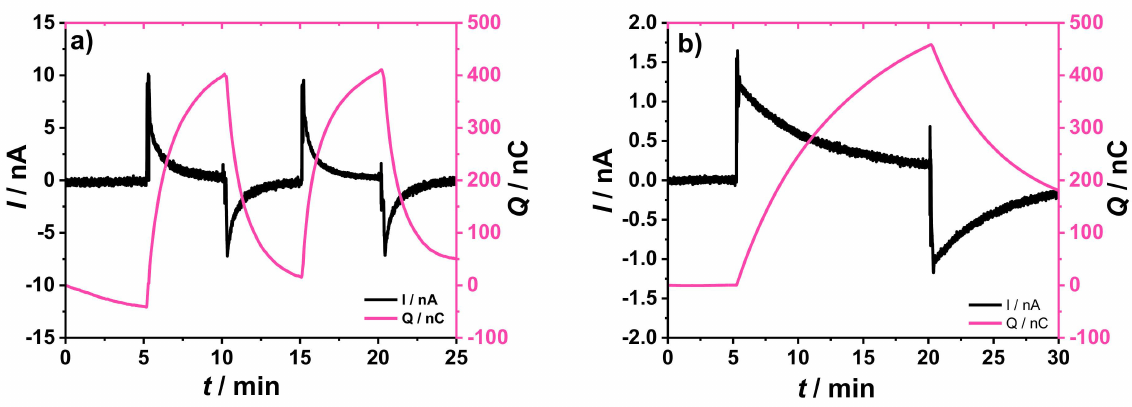
Figure 5. Chronoamperometric and chronocoulometric response in the addition/dilution experiments using working electrodes with different DM thicknesses: ( a ) 3 mm GC/10 mC PEDOT:PSS/25 µ L DM and ( b ) 3 mm GC/10 mC PEDOT:PSS/100 µ L DM. The addition/dilution steps correspond to a